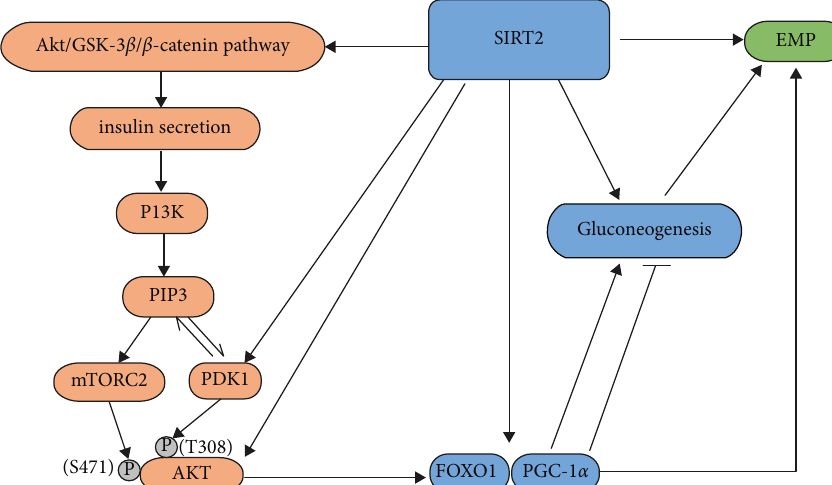
Figure 2: SIRT2 is involved in glucose metabolism. SIRT2 promotes gluconeogenesis by deacetylating FOXO1 and PEPCK. SIRT2 can promote glycolysis by interacting with glycolytic enzymes. SIRT2 can promote insulin secretion through the Akt/GSK-3 β / β -catenin pathway. SIRT2 can also regulate glucose metabolism through the insulin-PI3K-AKT-metabolism pathway. AMPK can phosphorylate and activate SIRT2 and enhance the interaction between SIRT2 and AKT. In addition, SIRT2 can activate AKTand PDK1 through deacetylation, thereby promoting glycolysis and inhibiting